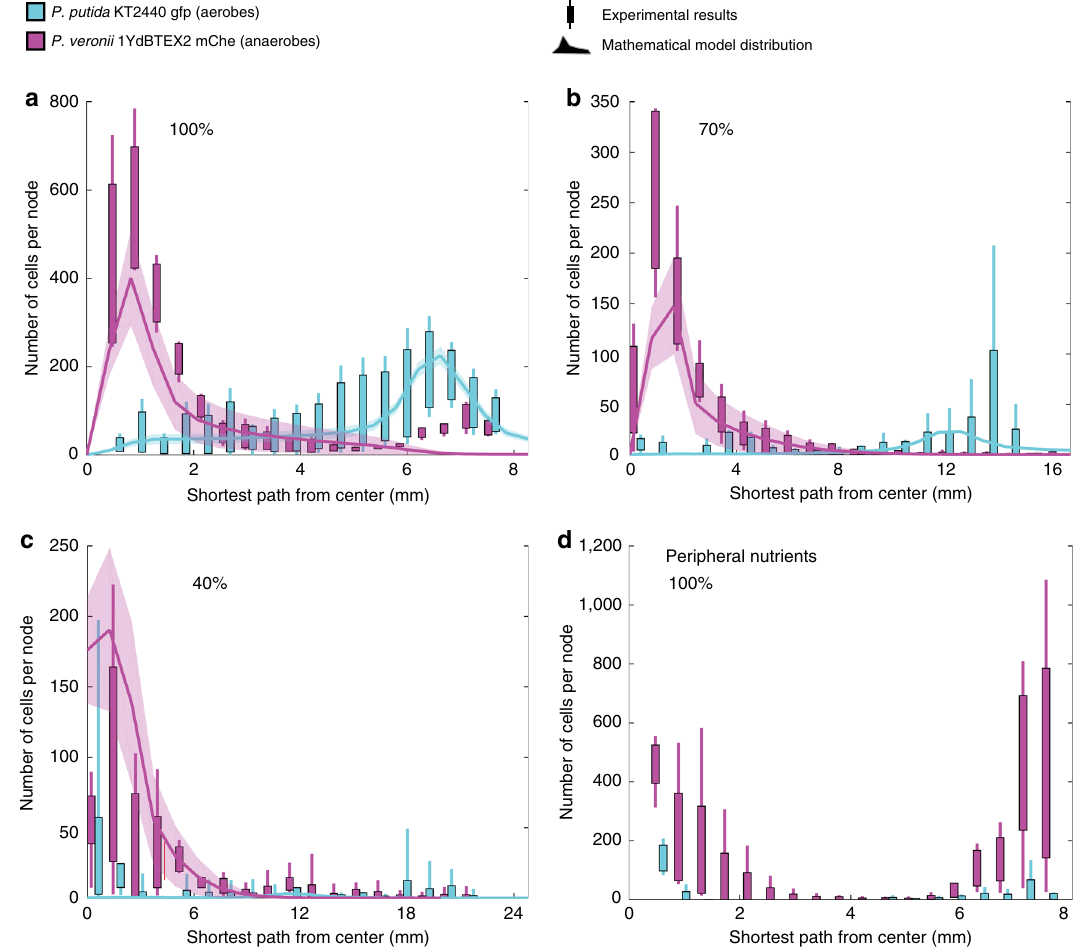
Fig. 4 Distribution of aerobes and anaerobes as a function of spatial positioning within the different pore networks. Results show combined experimental cell distribution and simulation results from the mathematical model for all pore network connectivities ( a – c ), using counter-gradients of citrate (maximum concentration at center port) and oxygen (maximum concentration at peripheral ports). Experimental results are represented in boxplots (whiskers indicate minimum to maximum value of data) of three, four, and fi ve experimental replicates for the 100%, 70%, and 40% pore networks, respectively. In the mathematical model results, thick line indicates the mean and shaded area includes 95% of all cells. In the experiments, bacterial cells in fl uorescence microscopy images were identi fi ed using digital image analysis, mapped onto the pore network, and attributed to the closest nodes. These were subsequently grouped into bins with respect to their shortest path from the central port. A pore-scale segregation of the two species is visible within each connectivity. In the 40% lattice, the distribution is less clear due to perturbations of the pore network geometry. To test the role of counter-gradients, the experimental results in d depict bacterial distributions for carbon and oxygen collocated at the peripheral ports (eliminating counter-gradients) resulting in dominance of facultative anaerobes at both the central and peripheral ports. Simulations of this scenario would result in the dominance of aerobes at the peripheral port due to the (simpli fi ed) representation of P. veronii as an obligate